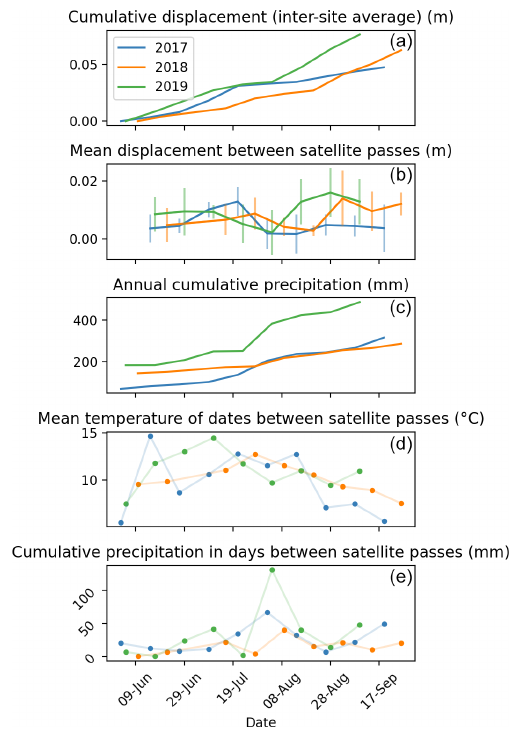
Figure 4. InSAR displacements versus climate variables during the corresponding satellite passes: (a) cumulative displacement; (b) dif- ferential movement (vertical error bars are 1 standard deviation across the five sites); (c) cumulative precipitation during the satellite recording time; (d) 12d rolling average temperature between satel- lite passes; (e) 12d cumulative rainfall between satellite